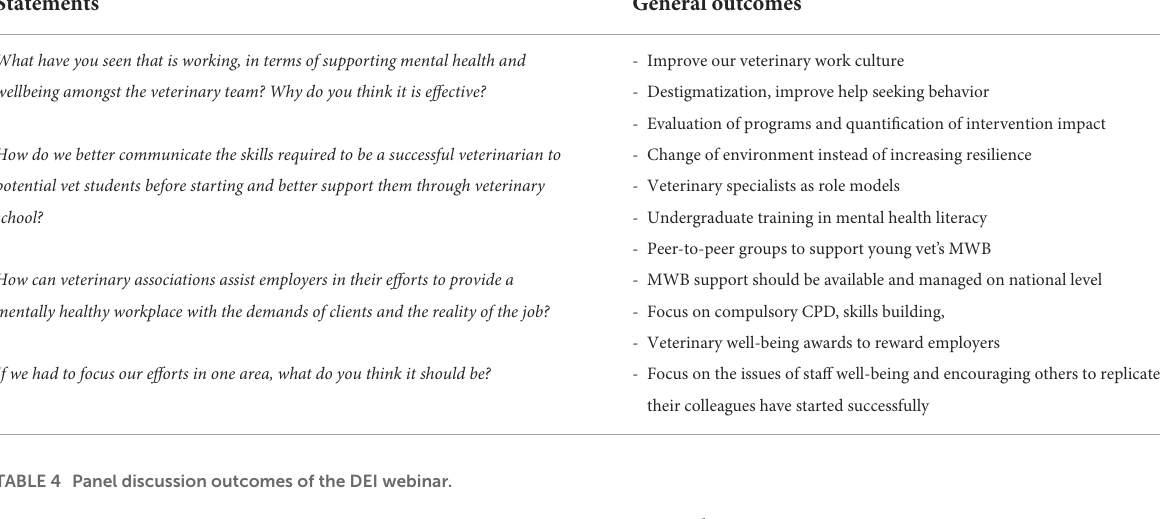
TABLE 3 Panel discussion outcomes of the MWB webinar.